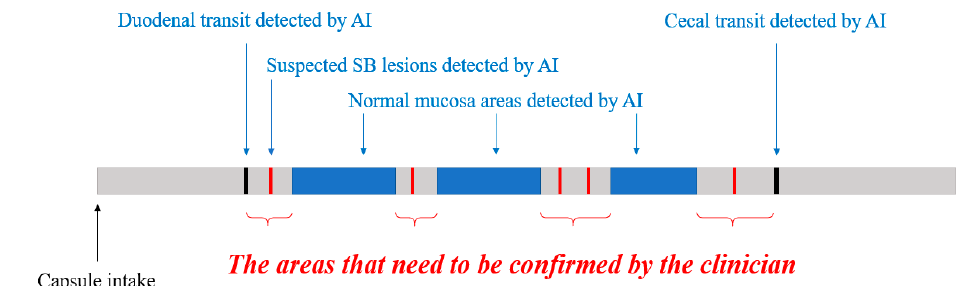
6 of 9 Figure 1. Examples of detection error in the binary classification of artificial intelligence (AI) reading . The bile, vascular structure, bubble, and normal mucosal fold were mistaken for significant lesions in AI reading. 3.3. New Consensus on the Small Bowel Lesions Capsule endoscopy structured terminology (CEST) was proposed in 2005 as a stand- ardized terminology in SBCE [48]. However, it is not easy to use it in clinical practice due to its complexity. Moreover, inter-observer variability related to the lesion can occur for each clinician, except for clear lesions such as deep ulcers and active bleeding [49]. An ambiguous detection such as a simple hyperemic spot or lymphofollicular hyperplasia may not be related to the small bowel disease. To use the AI algorithm in medical aspects, consensus on the clinically significant small bowel lesions is required. 4. Conclusions SBCE reading via an AI algorithm showed high accuracy for lesion detection. How- ever, it essential to study fully reliable AI algorithms that read full-length capsule endos-